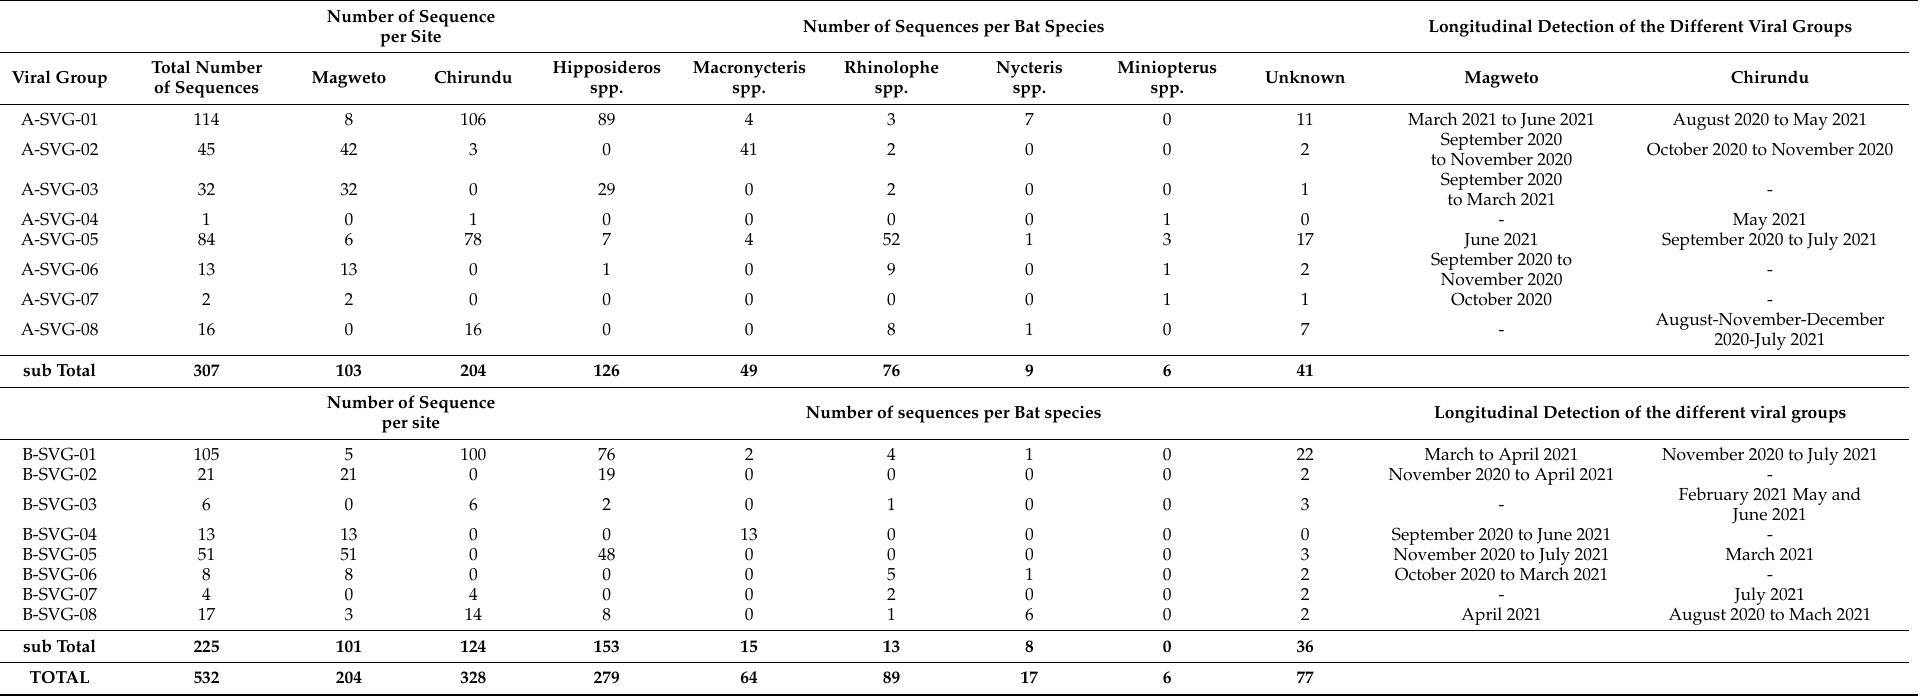
Table 2. Longitudinal detection of different viral groups in Magweto and Chirundu